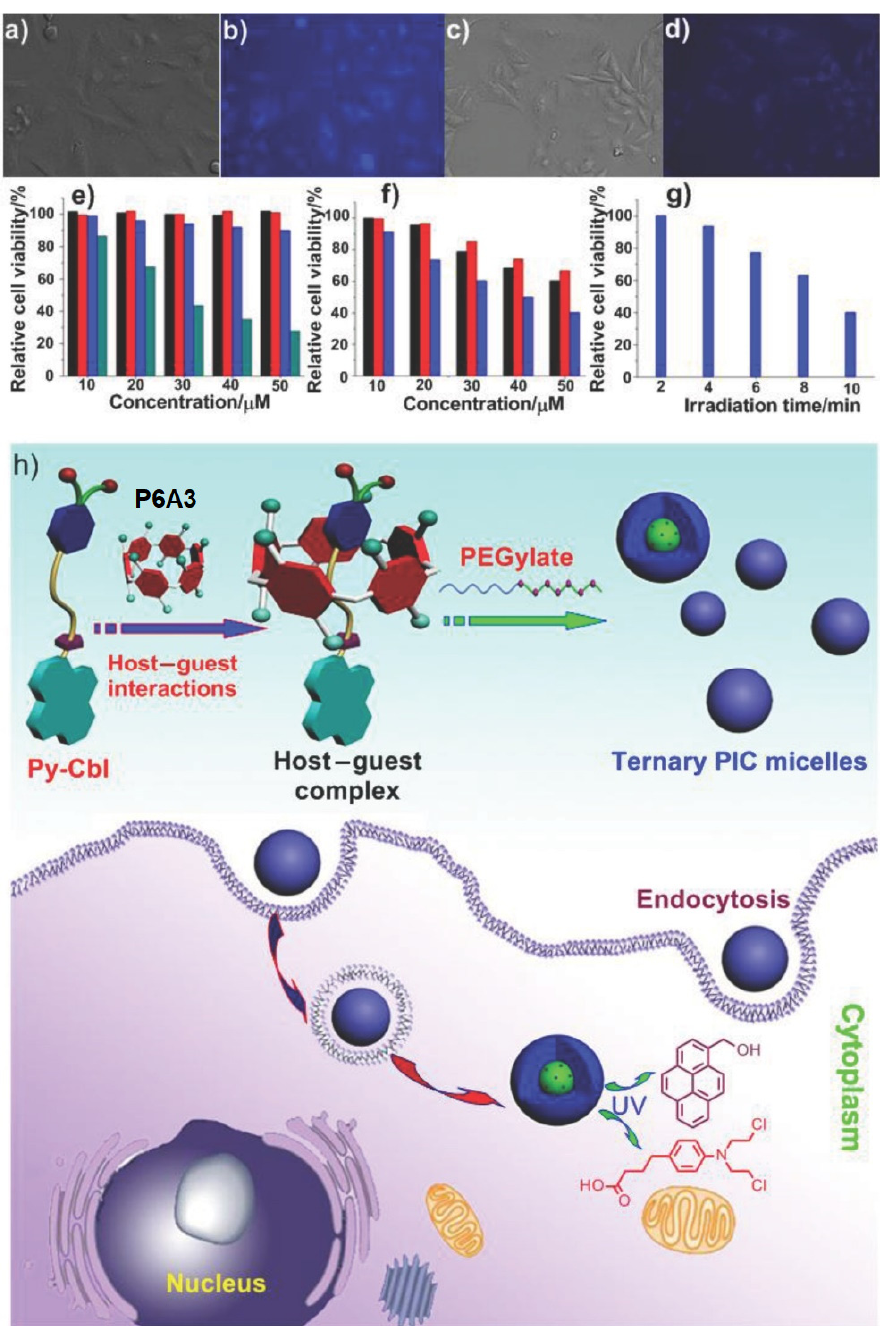
Figure 18. Real-time drug release studies using fluorescence microscopy: ( a ) bright field image of A549 cells incubated with Py-Cbl before UV light irradiation; ( b ) fluorescence image of ( a ); ( c ) bright field image of A549 cells incubated with Py-Cbl after UV light irradiation for 10 min; ( d ) fluorescence image of ( c ); ( e ) cell viability tests of Py-Cbl ( black column ), “ P6A3*Py-Cbl ” ( red column ), ternary complex ( blue column ), and chlorambucil (cyancolumn) against A549 cells; ( f ) cell viability tests of A549 cell line in the presence of different concentrations of Py-Cbl (black column), “ P6A3*Py-Cbl ” ( red column ), and ternary complex ( blue column ) after UV irradiation for 10 min; ( g ) cell viability tests of A549 cell line in the presence of the ternary complex after UV irradiation for different times; the concentration of Py-Cbl was 5 × 10 − 5 M; ( h ) schematic illustration of the preparation of ternary PIC micelles and possible cellular pathways; the ternary PIC micelles are endocytosed by cancer cells and chlorambucil is released upon UV irradiation. Reproduced with the permission of refer- ence [100]. Copyright © Wiley 2015.